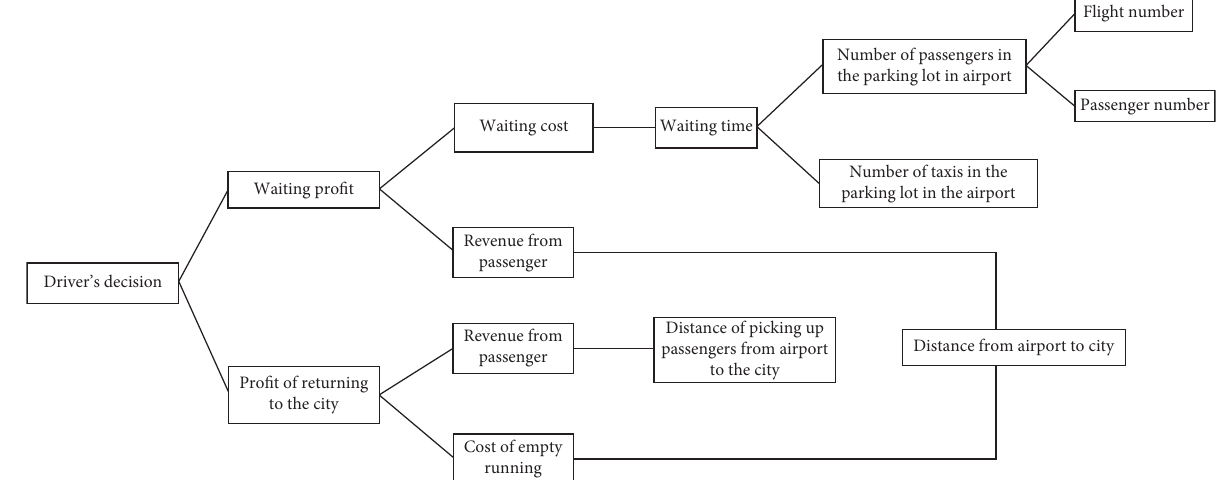
Figure 1: Cost-benefit analysis